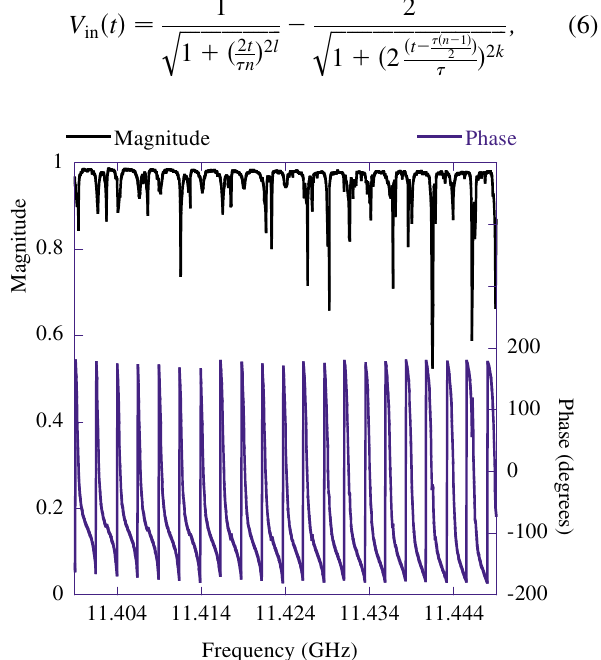
FIG. 10. (Color) Frequency response of the dual-moded delay line with an iris inserted between the mode launcher and the delay line. The iris has a reflection coefficient of 0.607.